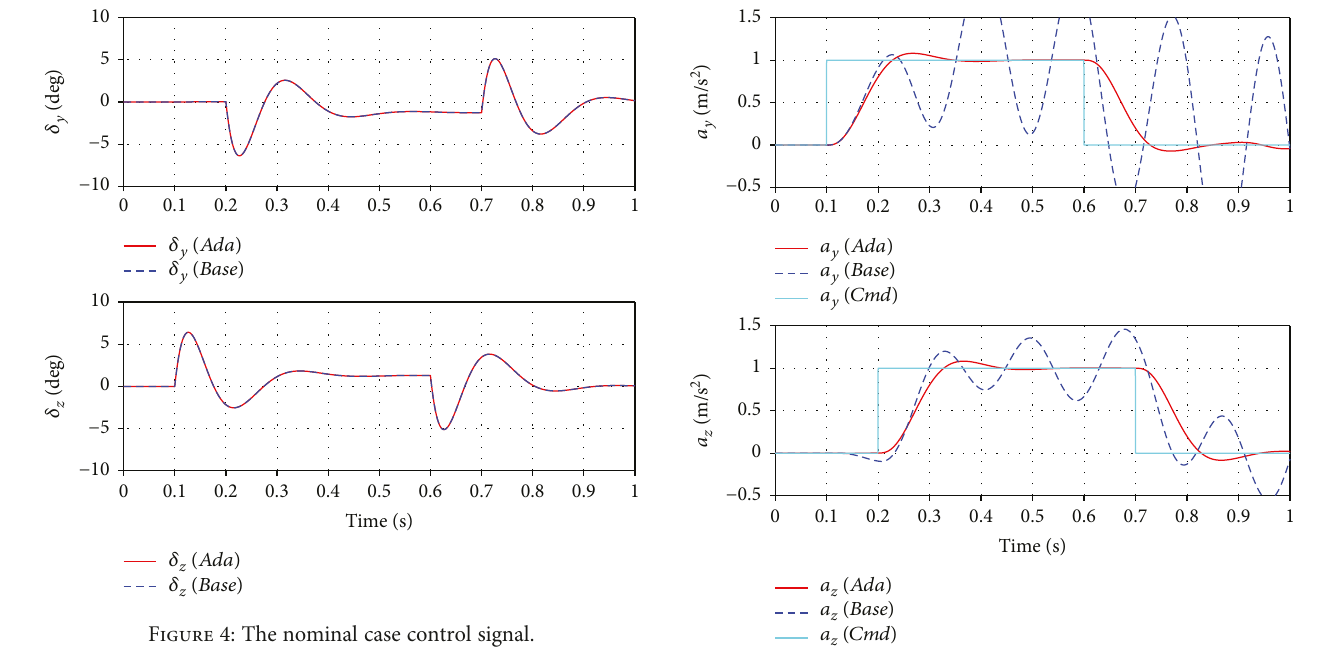
Figure 6: The uncertain case tracking performance.